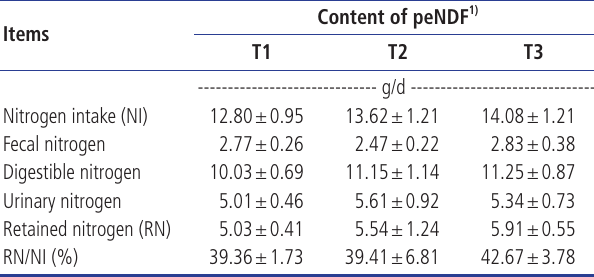
Table 6. Nitrogen balance of Korean native goats fed the TMR feed with different peNDF contents Items